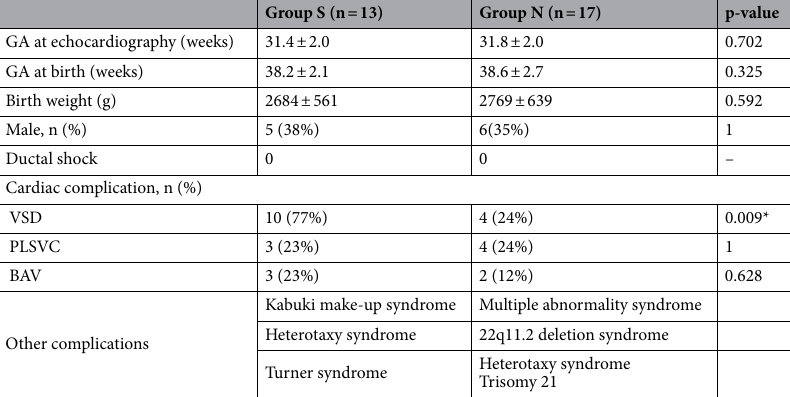
Group S (n = 13) Group N (n = 17) p-value RVEDD 0.5 ± 1.2 0 ± 1.7 0.263 0.6 ±